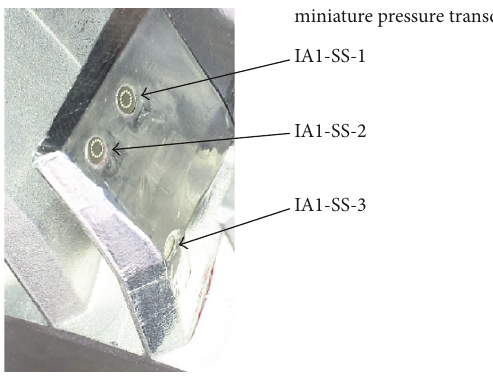
Figure 4: Flush mounted pressure transducers in blade (labels according to Figure